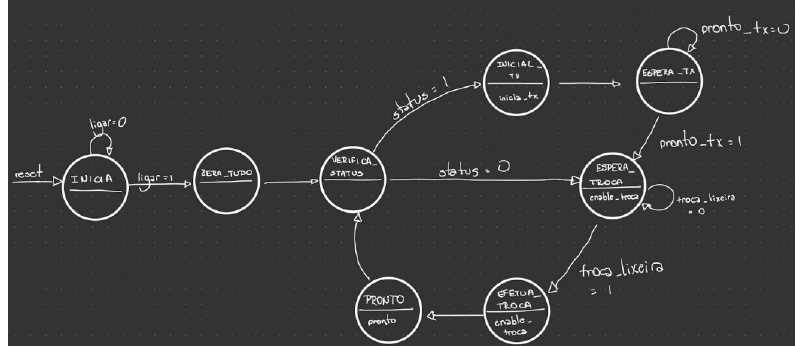
Figure 11. Finite state machine of the control